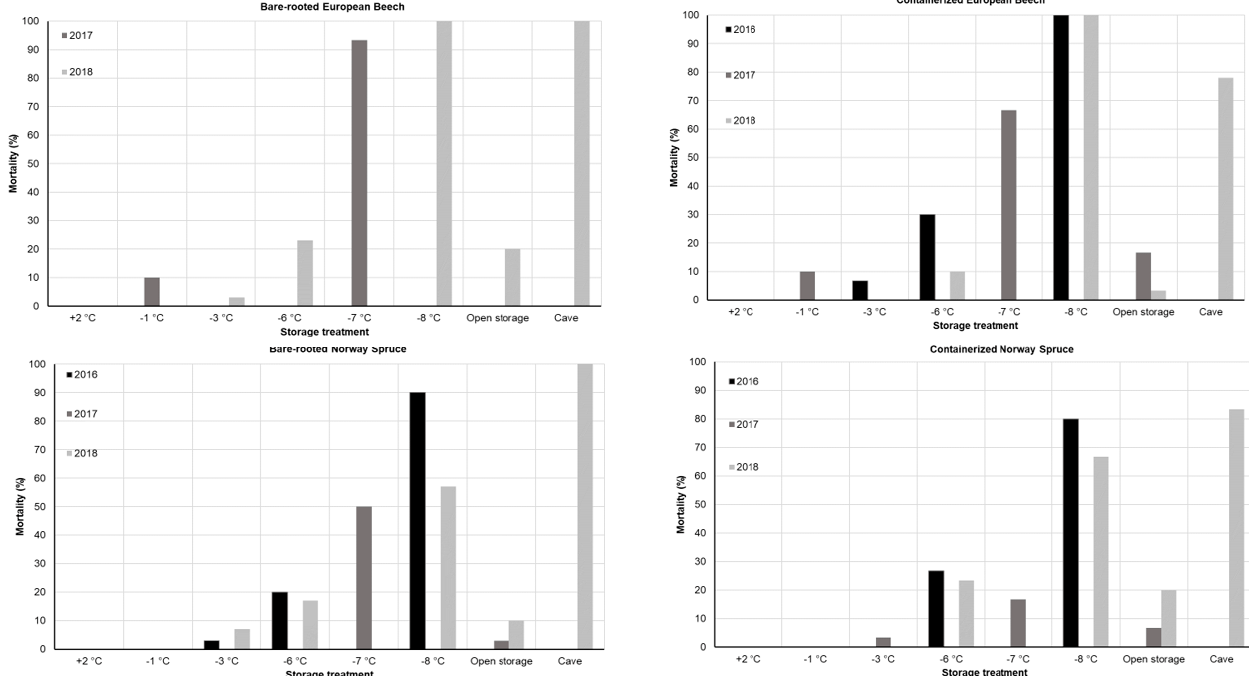
Figure 5. Mortality of the bare-rooted and containerized European beech and Norway spruce plants in the various storage treatments at the end of the first growing season in three years of the research. Statistically significant differences in the heights of the plants at the end of the grow- ing season were found between the different types of storage treatment (Table 3). It is not